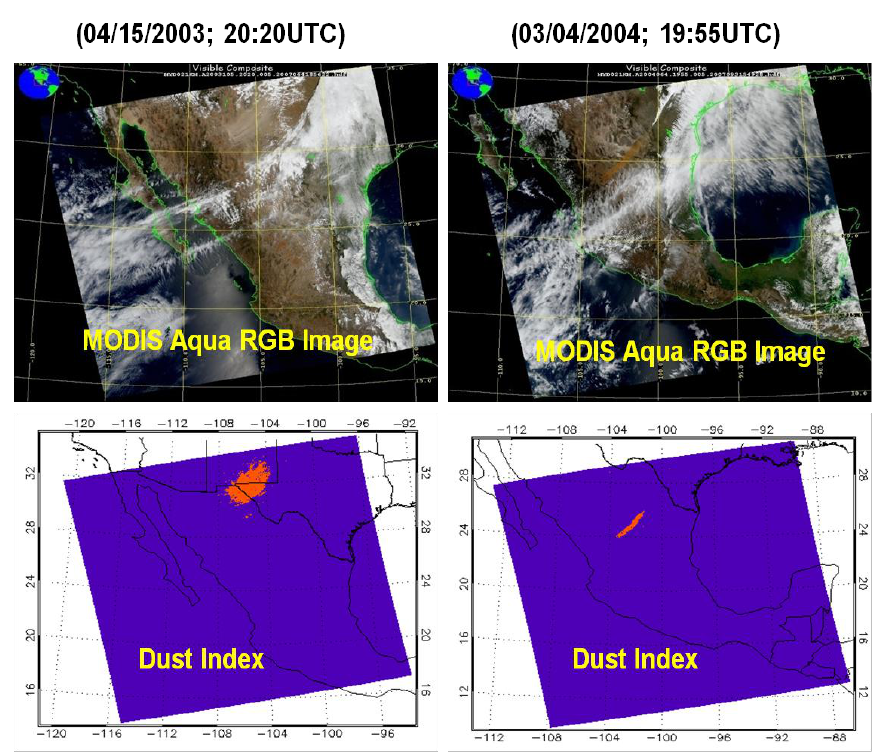
Figure 15. Top: Red-green-blue (RGB) false color images of Aqua MODIS observations. Bottom: The results of the dust test where pixels flagged as dusty are